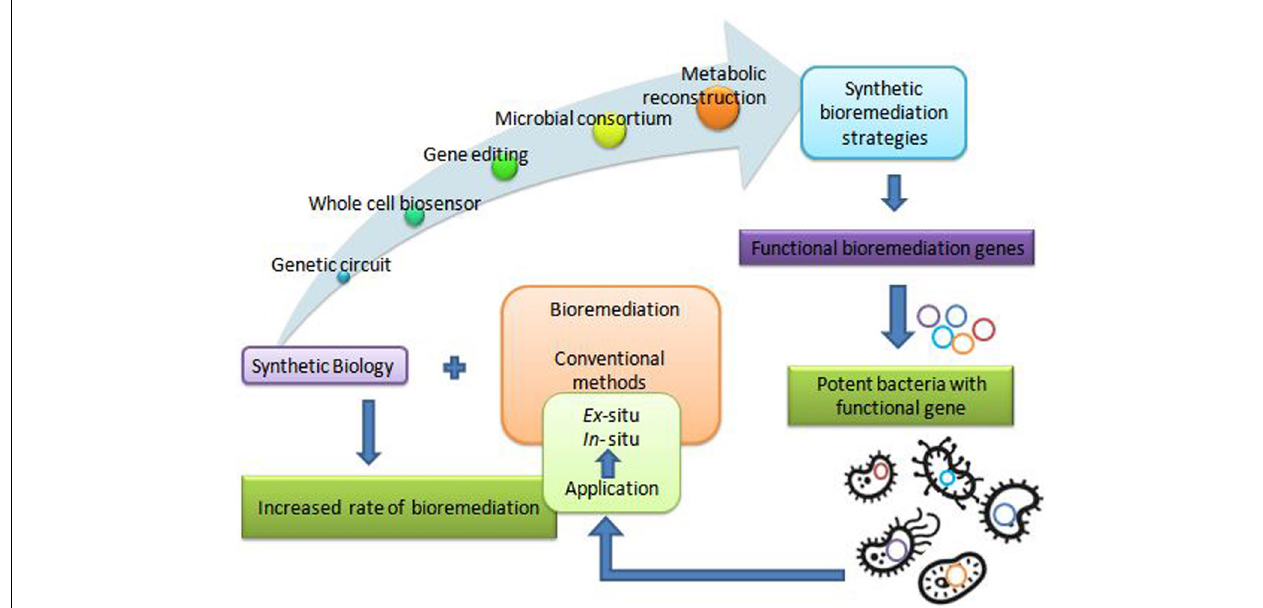
FIGURE 1 | The strategies of synthetic biology applicable for bioremediation.